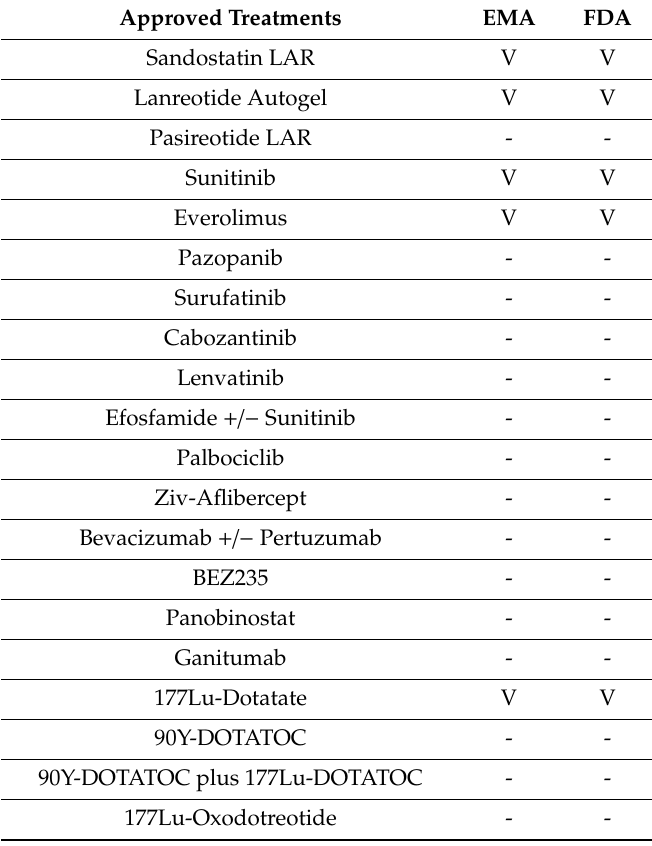
Table 2. Approved systemic treatment options for PanNET by FDA and